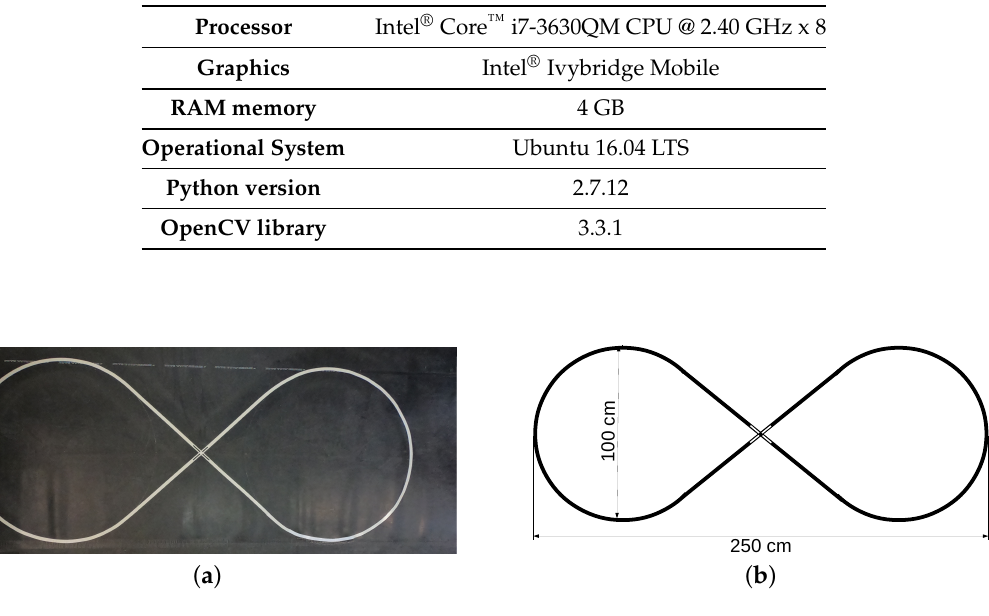
Figure 17. Eight-shaped lane used in experimental trials. ( a ) the real lane; ( b ) lane schematic.